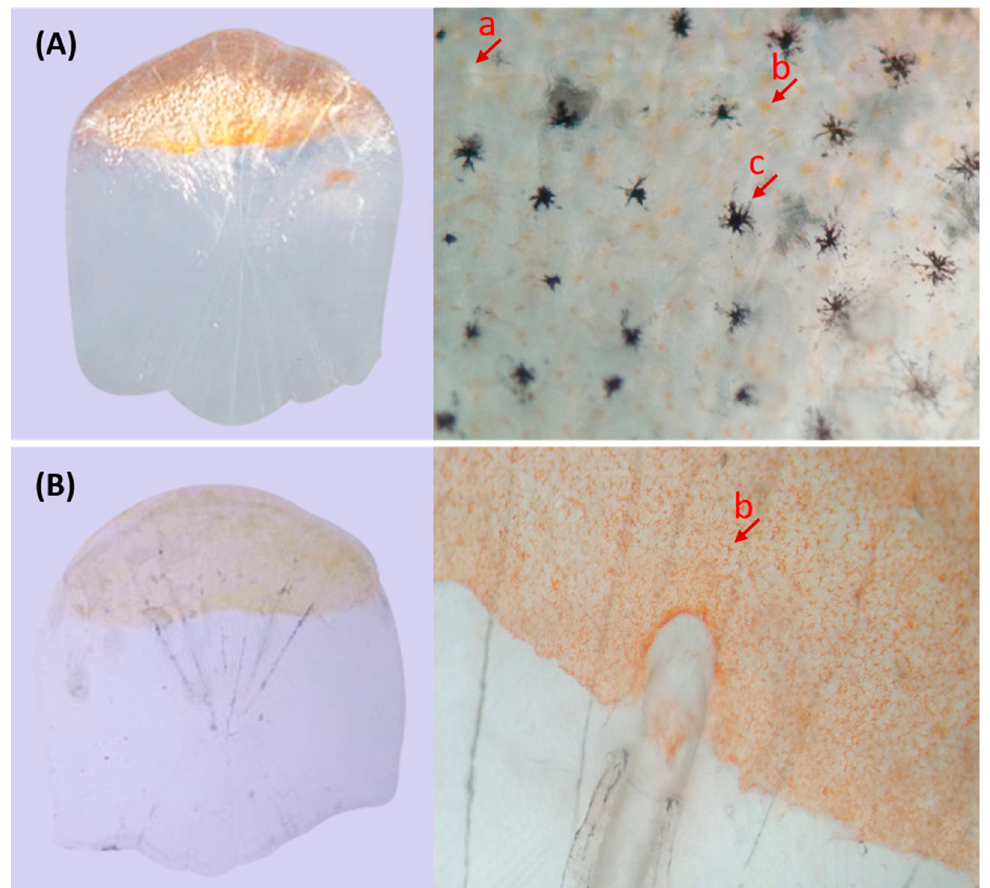
Figure 2. Microscopic observation of scales. ( A ) Scales of WT; ( B ) Scales of TM. a: sliver pigment; b: yellow pigment; c: melanin